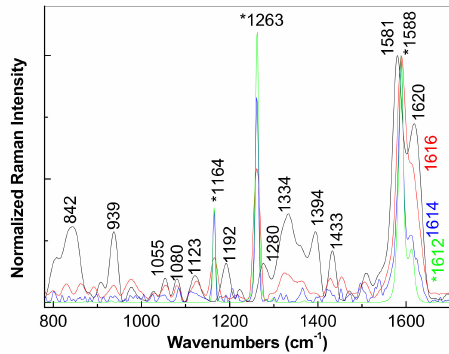
Figure 11. The Raman spectra of PDITC (green curve) before and after the adsorption onto the Au electrode covered with the RGO sheets covalently functionalized with P5A1N doped with H 4 SiW 12 O 40 heteropolyanions using 2 mL (blue curve), 1 mL (red curve) and 0.5 mL (black curve) of the PDITC in C 2 H 5 OH solution at the concentration of 1 mg /